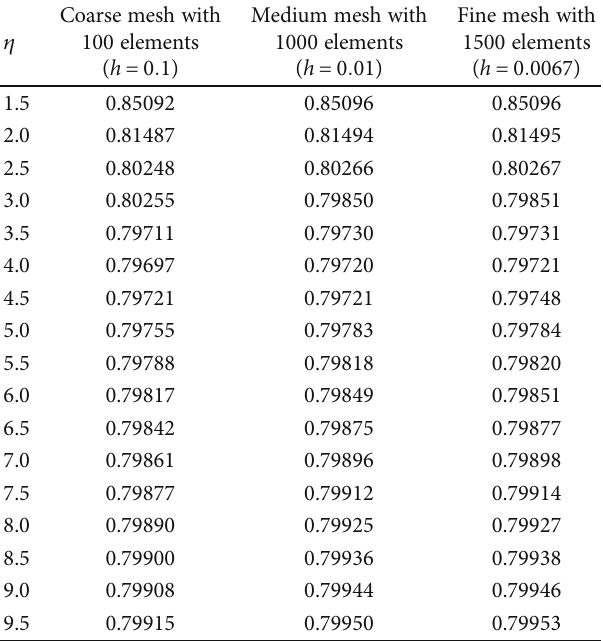
Table 2: Grid-independence test for temperature